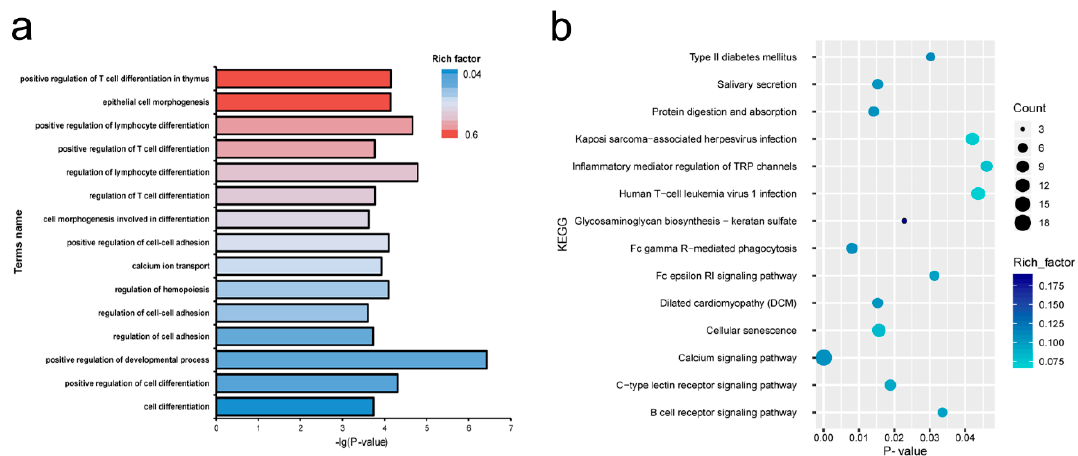
Figure 3. ( a ) Enriched biological process for target genes of differentially expressed miRNAs genes between lactating and non-lactating pigeon crop. ( b ) KEGG pathways enriched in target genes of the differentially expressed miRNAs between lactating and non-lactating pigeon crops.